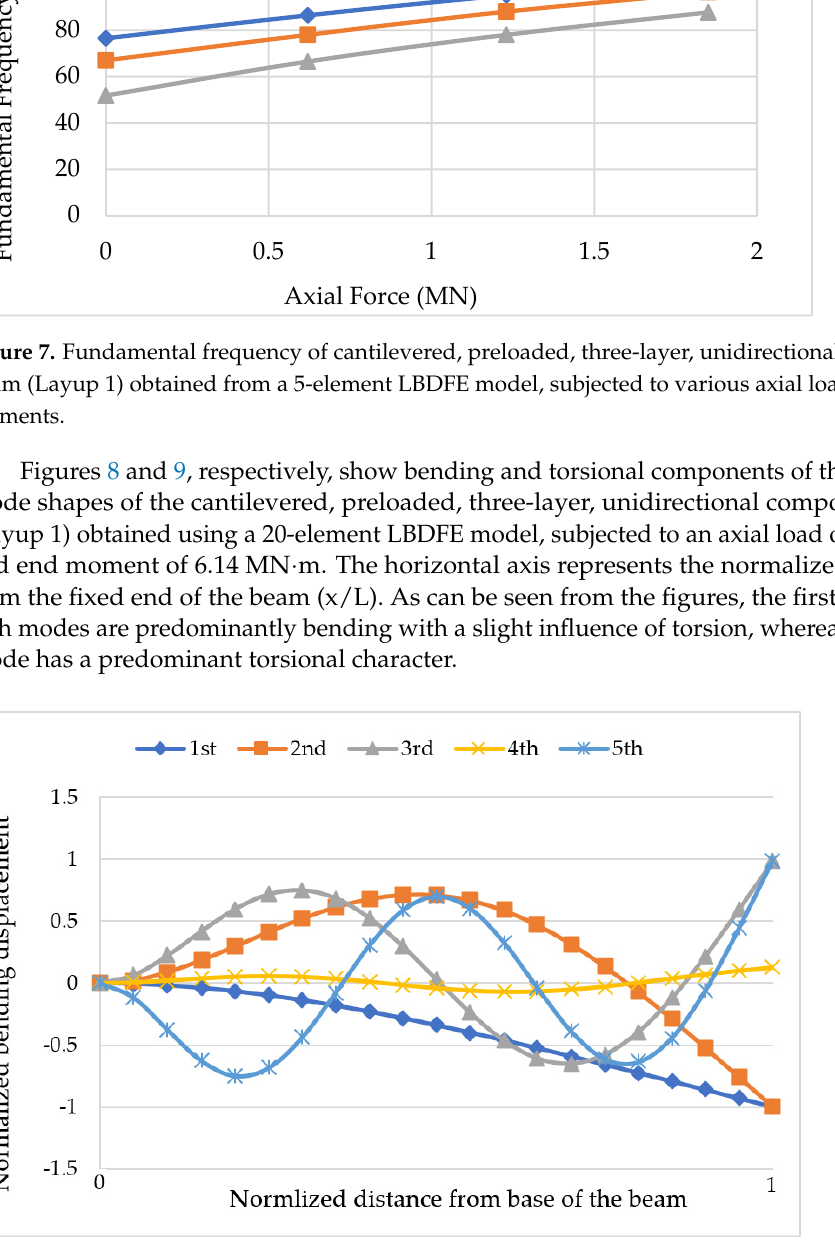
Figure 9. Torsion component of the first five mode shapes of the cantilevered, preloaded, three- layer, unidirectional composite beam (Layup1) obtained using a 20-element LBDFE model, sub- jected to an axial load of 1.85 MN and end moment of 6.14 MN·m. 4. Discussion The free vibration analysis of Fiber-Metal Laminated (FML) and unidirectional com- posite beams subjected to axial force and end moment is presented using layered Finite Element Method (FEM) and Dynamic Finite Element (DFE) models. The frequency results are compared with those obtained from the conventional FEM (ANSYS) as well as the homogenization technique. Based on the results shown in Table 1, the presented layered FEM method has higher a rate of convergence compared to the method of homogenization while DFE has a higher rate of convergence compared to the FEM method, which makes DFE the most efficient method. Considering the benchmark, the estimated error of the FML beam fundamental frequency for the DFE method using five elements along the beam length is almost zero. This error for the layered FEM method using five elements, is around 0.64% while for the method of homogenization using the same number of